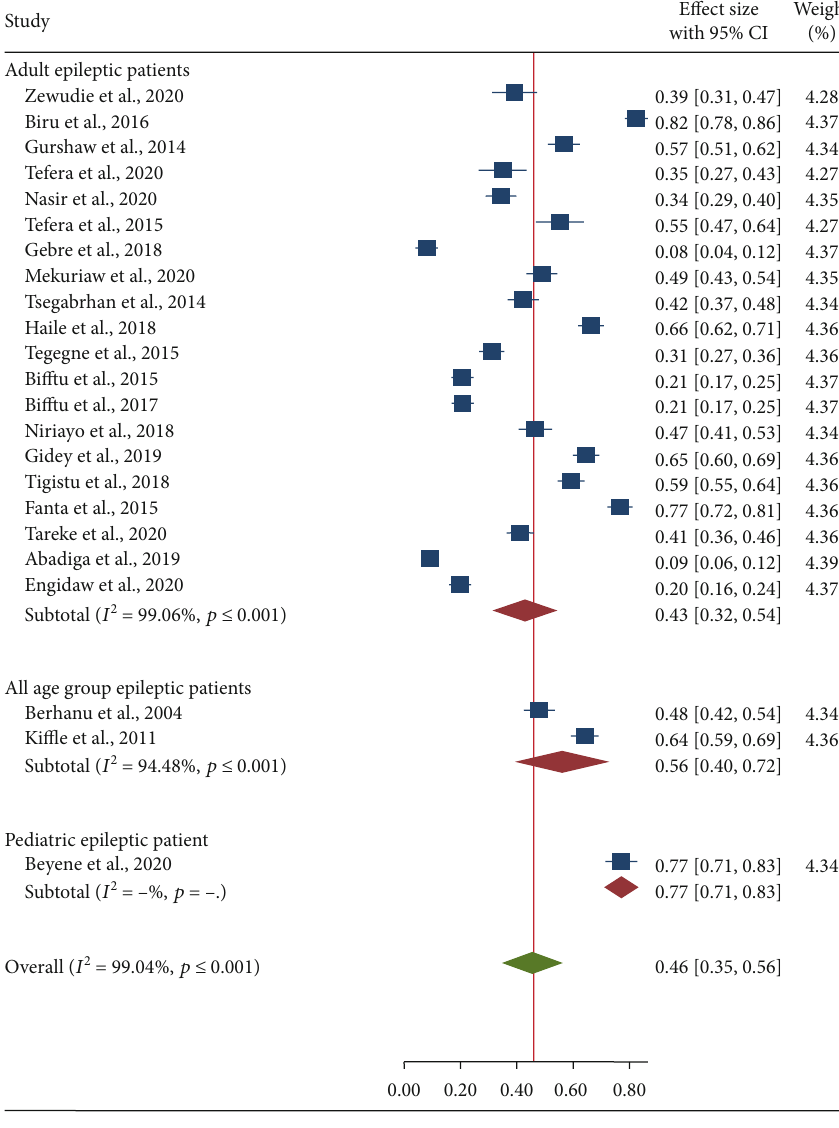
Figure 4: Forest plot depicting subgroup analysis of seizure freedom by age